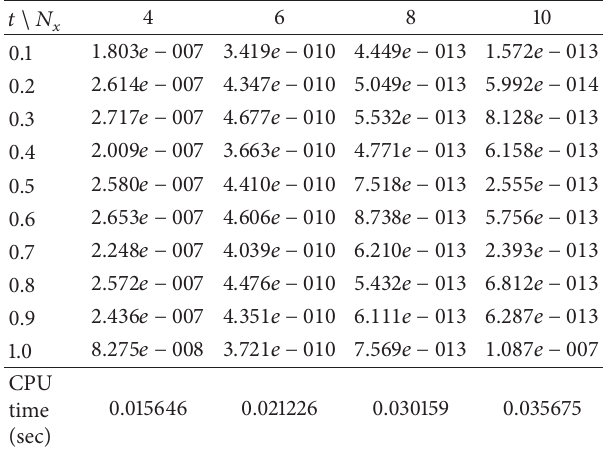
Table 5: Maximum errors 𝐸 𝑁 for the modified KdV-Burgers equation, with 𝑁 𝑡 = 10 .